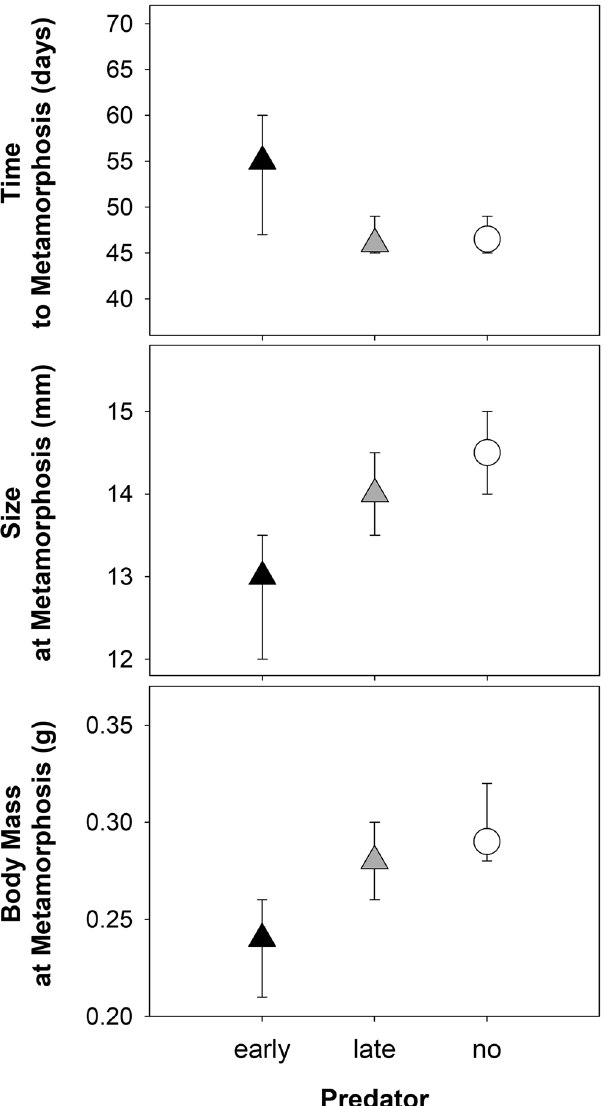
Figure 1. Time to metamorphosis and size and body mass at metamorphosis (median and interquartile range) in the